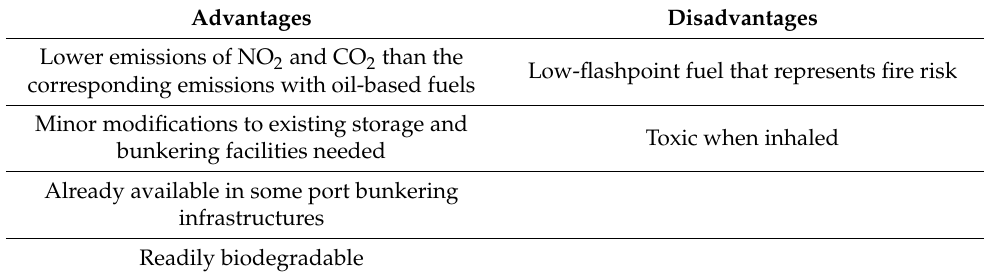
Table 6. Cont. Advantages Disadvantages Lower emissions of NO 2 and CO 2 than the Low-flashpoint fuel that represents fire risk corresponding emissions with oil-based fuels Minor modifications to existing storage